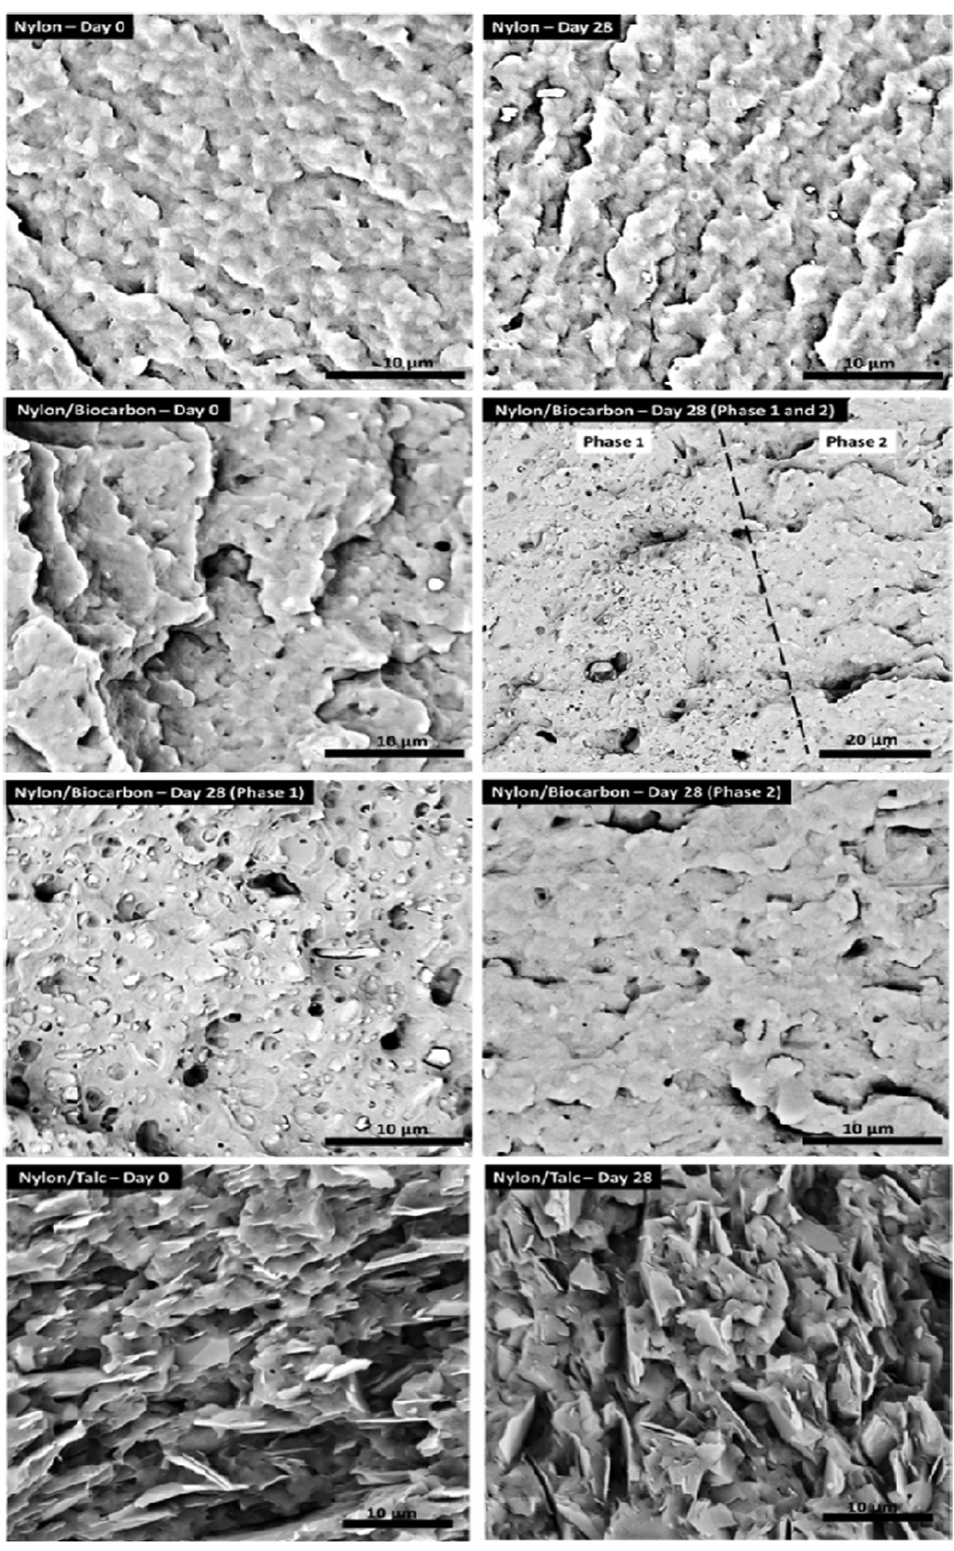
Figure 7. SEM micrographs of the impact fractured surfaces of PA, PA6–BC, and PA6–talc before and after conditioning for 28 days [81]. Reproduced with permission from Elsevier Science Ltd. 2017, Elsevier Science Ltd.